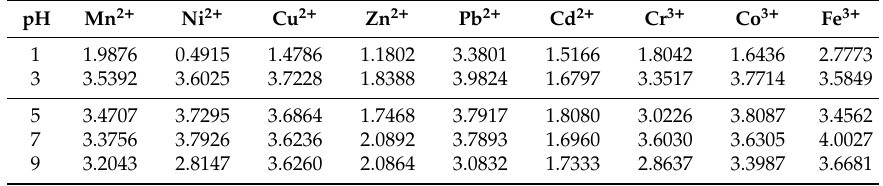
Table 6. Distribution coe ffi cient (log D) values against di ff erent pHs on P (AA / Kry23-DM)